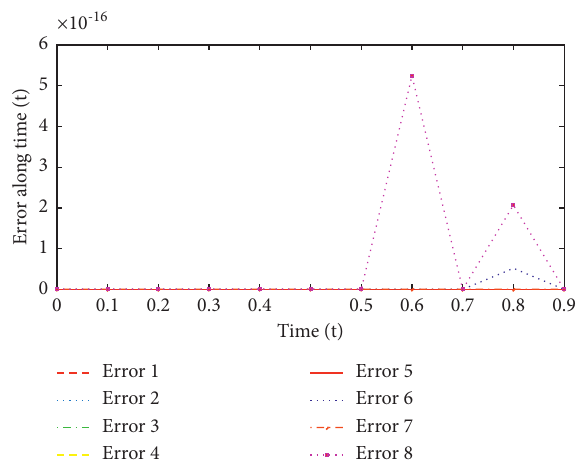
Figure 3: The error of the generator system solution for θ � e − t .